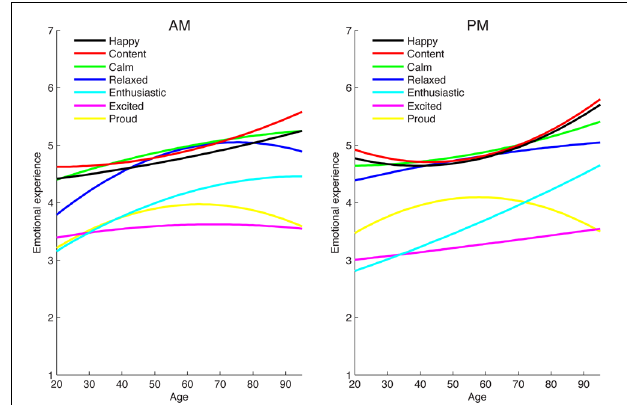
FIGURE 1 | Age differences in positive emotional experience in the morning (AM) and evening (PM).